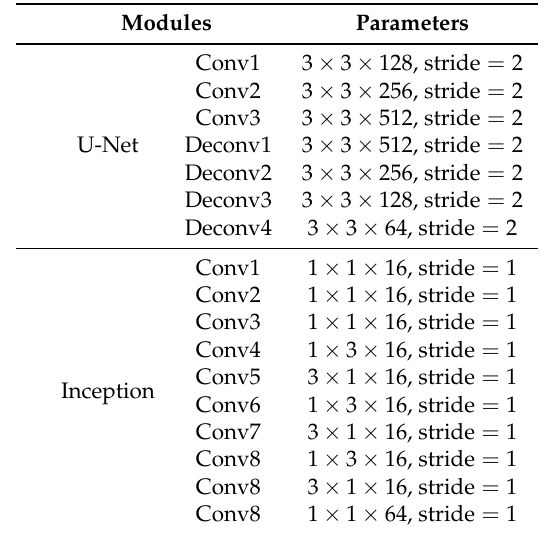
Table 2. Some key parameters in the lung parenchyma region segmentation sub-network